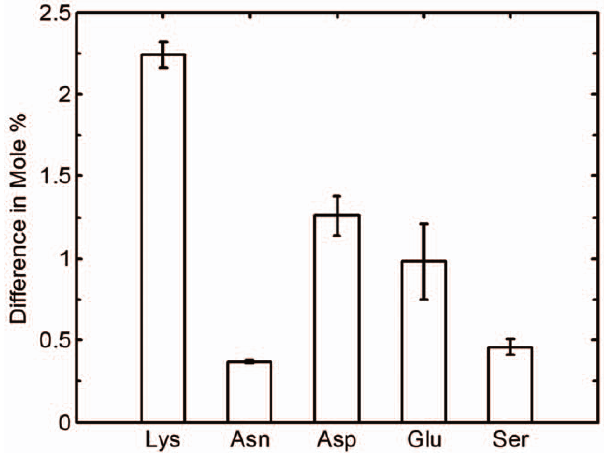
Figure 8. Mole percentage difference for the amino acids lysine, asparagine, aspartic acid, glutamic acid and serine, obtained by enzymatic digestion comparing a control untreat- ed honeybee silk sponge to a sponge sample heat treated at 190 6 C for 60 minutes.